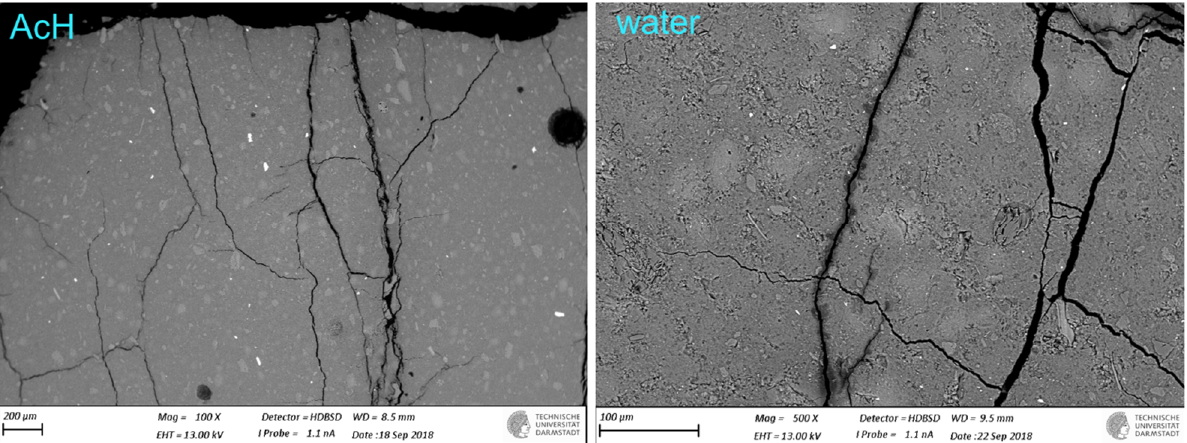
Figure 6. SEM ‐ BSE images of the specimen’s surface layers exposed to leaching in acetic acid (AcH, left) and Water (right). The acid penetrates from the upper side of the image.